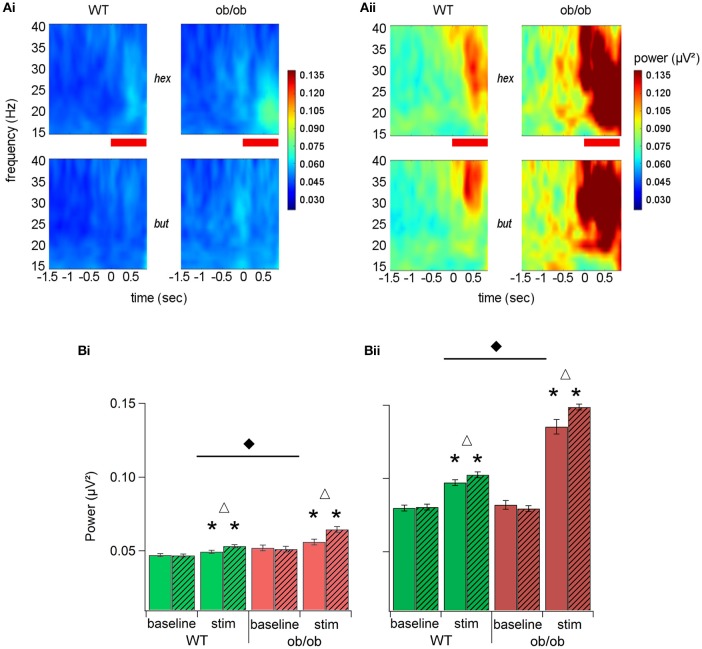
Learning increased beta oscillatory activity in both groups but oscillations were stronger and longer in ob/ob mice. (A) Beta band (15–40 Hz) time-frequency power plots averaged across all mice (WT n = 14; ob/ob n = 10) for beginner (Ai) and criterion (Aii) levels. The two odors (hex, hexanal: Go; but, butanal: No-Go) are represented separately as marked. Zero on the time axis is the time of the nosepoke trigger of the odor. The red horizontal bar is the odor delivery period. Color scale indicates power and is consistent for the two panels. (B) Mean power (±SEM) of the beta band (15–40 Hz) averaged across all mice (WT n = 14; ob/ob n = 10) for beginner (Bi) and criterion (Bii) levels for the two odorants of the pair (empty bars: hexanal; hatched bars: butanal). All mean values during odor stimulation were significantly above the mean for the baseline period (*Wilcoxon test p < 0.0001). Delta indicates significant differences between the 2 odors. Black diamond denotes a significant difference between WT and ob/ob mice.